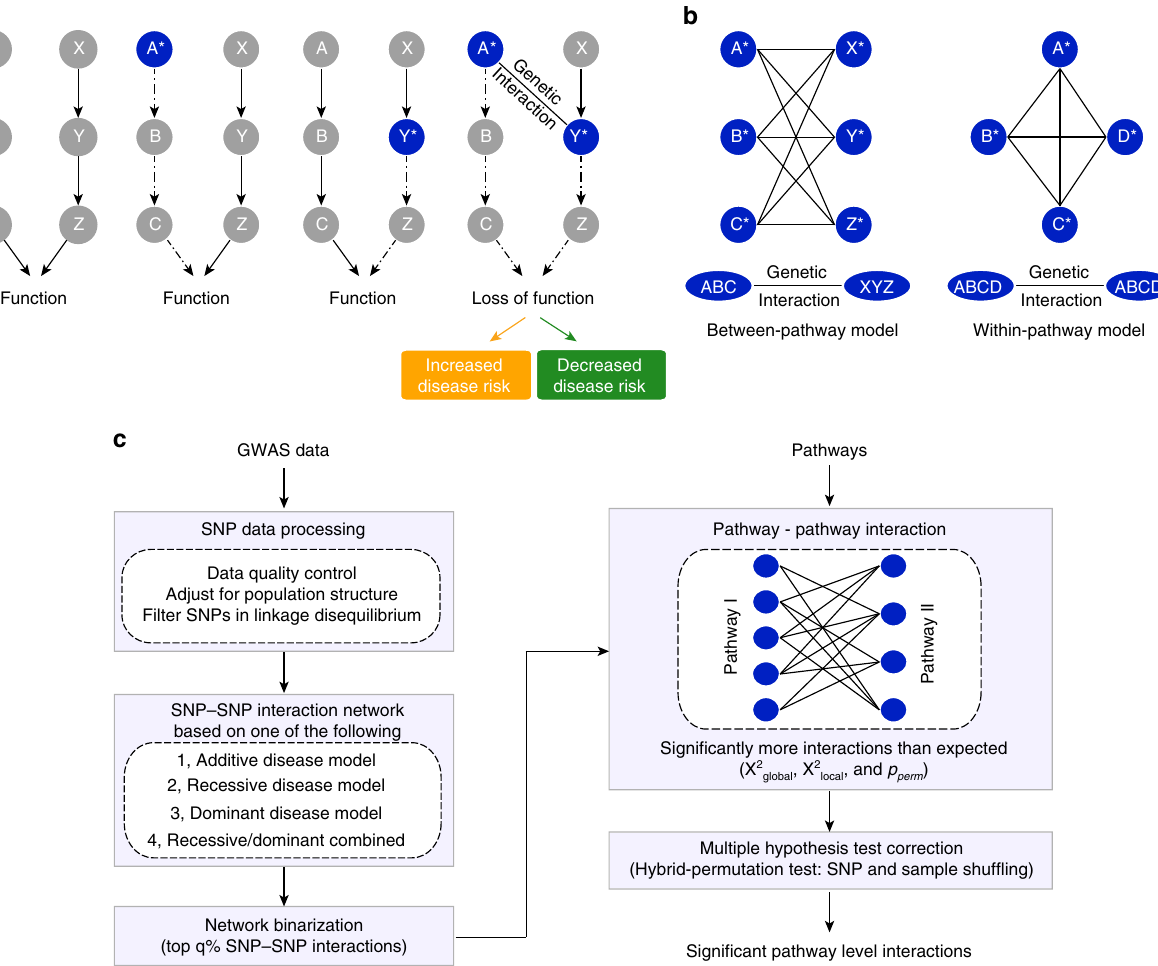
Fig. 1 Between-pathway and within-pathway model of genetic interactions. a Two distinct pathways, A → B → C and X → Y → Z converge to regulate the same essential function. Independent genetic perturbations in either pathway (indicated by blue color with an asterisk) have little or no contribution to a phenotype, but combined perturbations in both pathways in the same individual result in a genetic interaction, leading to a loss of function phenotype that can be associated with either an increase or decrease in disease risk. b The bipartite structure of genetic interactions (between-pathway model) resulting from functional compensation between the two pathways shown in a and the quasi-clique structure of genetic interactions based on the within-pathway model. Genetic perturbations in any pair of genes across the two pathways or within the same pathway combine to increase or decrease disease risk. Edges indicate observed interactions at the gene – gene or SNP – SNP level. c Conceptual overview of the BridGE method for detecting genetic interactions from GWAS